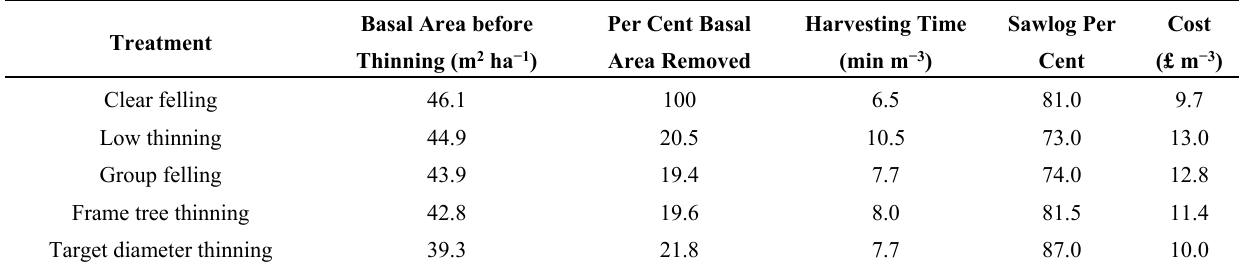
Table 5. Comparative harvesting outputs, sawlog outturn, and costs of standard operations and different transformation thinnings in a 37-years-old Sitka spruce stand (adapted from Price and Price, [87] (table 2 and figure